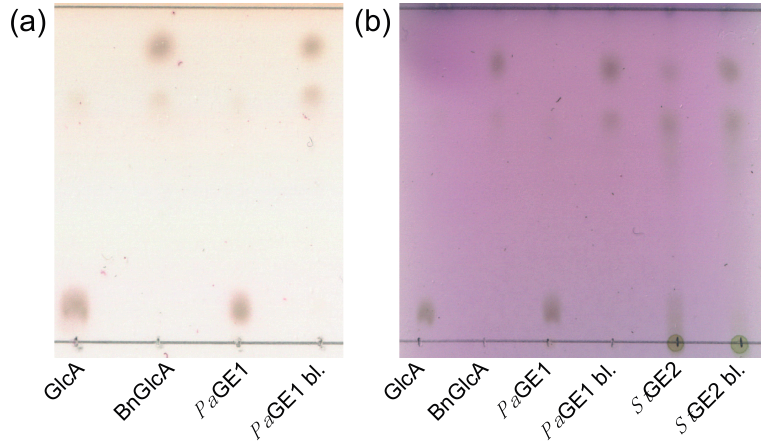
Figure 1. TLC chromatograms of two different plates. GlcA and BnGlcA were used as standards. As samples, BnGlcA that had been incubated with either of St GE2, boiled St GE2 ( St GE2 bl.), Pa GE1 or boiled Pa GE1 ( Pa GE1 bl.) was used. Plate ( a ) was developed using the N -(1-naphthyl)ethylenediamine dihydrochloride reagent and Plate ( b ) using the H 2 SO 4 -anisaldehyde